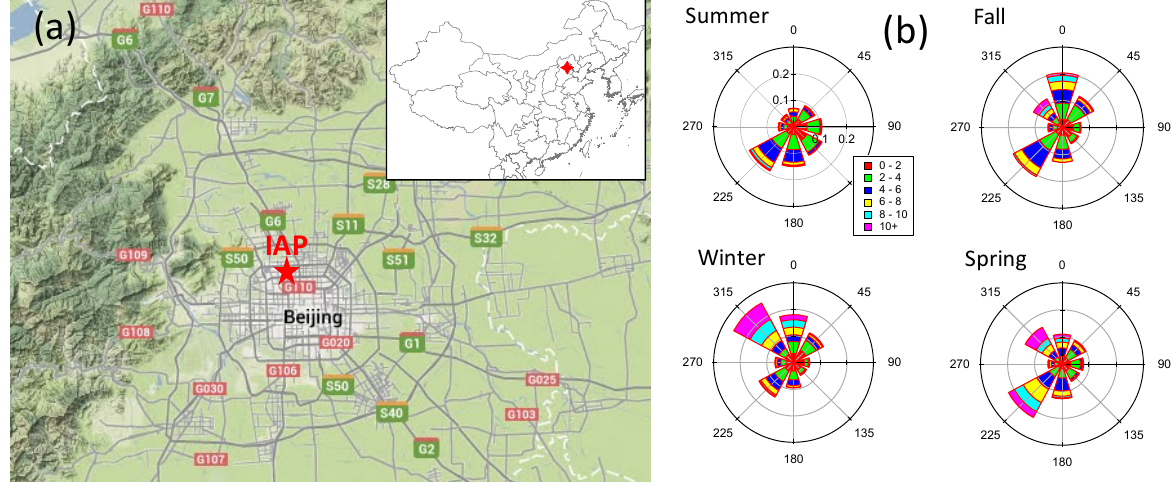
Figure 1. (a) Map of the sampling site (IAP). (b) Wind rose plots, color-coded by wind speed (ms − 1 ) for each season. The frequencies are set to the same scales for all